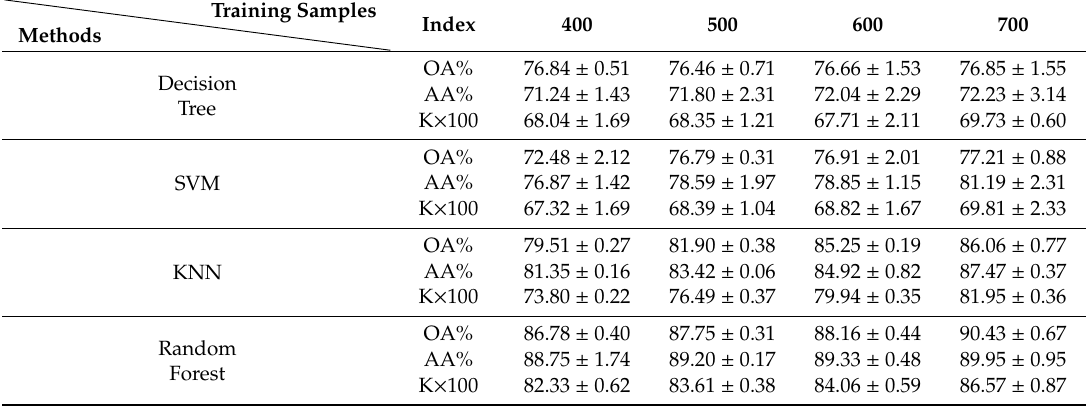
Table 2. Classification results of di ff erent training samples on Bayview Park data